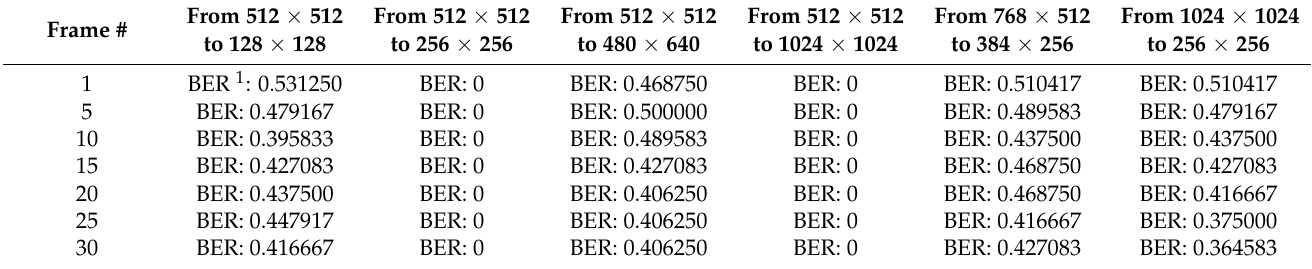
Table 11. Algorithm performance results for an encoded video fragment with a 128 × 128 encoder compressed with CRF = 16 when changing the video resolution: 96 bits decoding representation in the form of